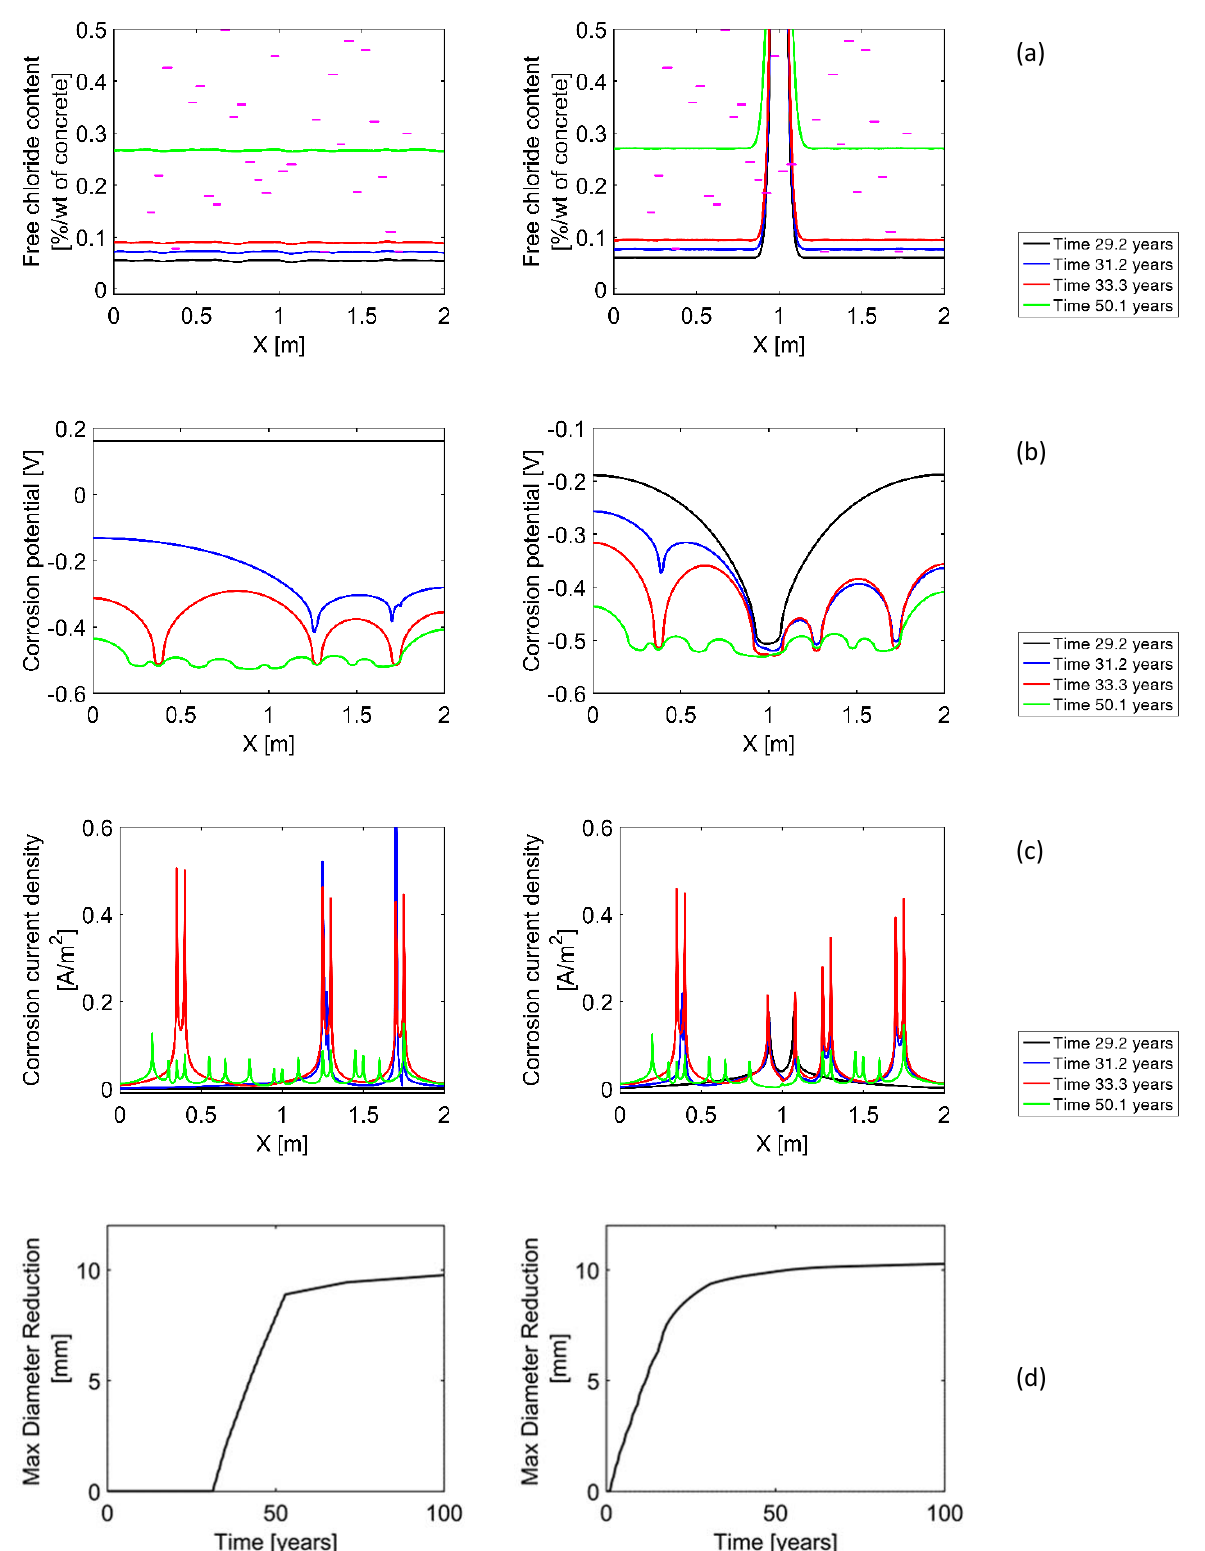
Figure 11 . 2D prediction for an un ‐ cracked (left) and a cracked beam (right) with geometry as shown in Fig. 9 of (a) chloride threshold (purple lines) and free chloride concentration at the reinforcement surface, (b) corrosion potential, (c) absolute corrosion current density, and (d) maximal rebar diameter reduction. After